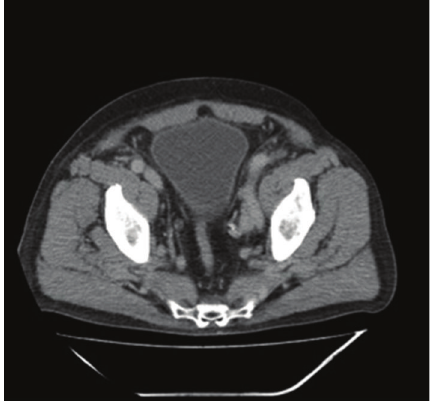
Figure 3: Presentation of an intraluminal ureteral mass of the right upper urinary tract in computer tomography of the